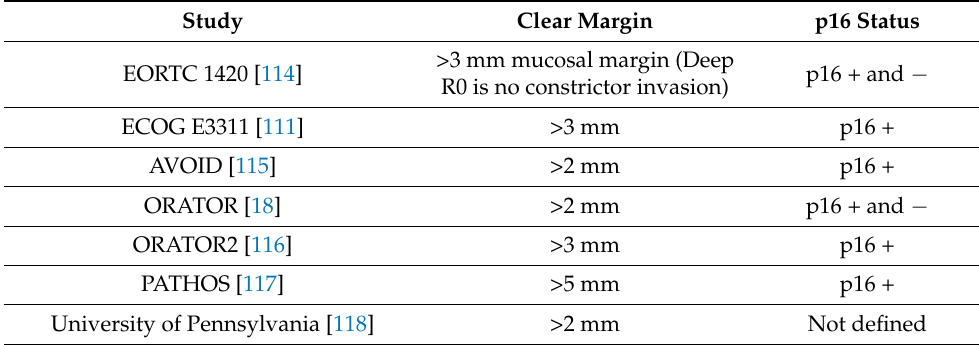
Table 3. Definition of R0 margins used in different studies on oropharyngeal